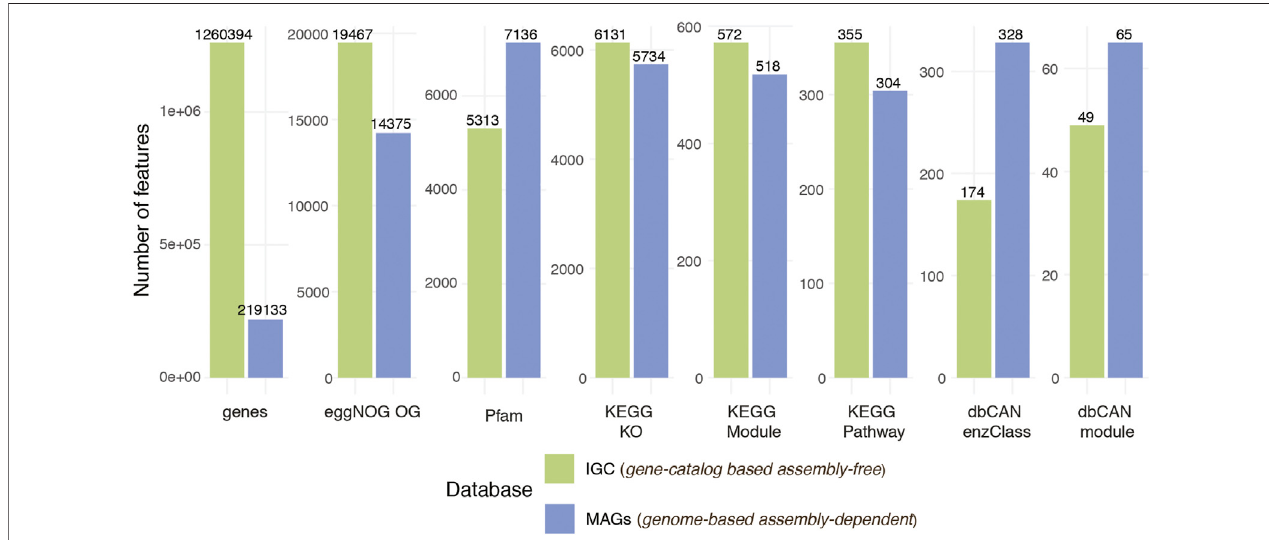
FIGURE 3 | Comparison of number of genes and features per function database between non-redundant high quality 163 MAGs and